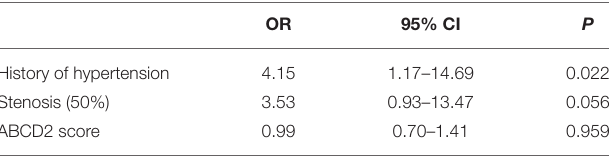
TABLE 2 | Possible predictors of T max ≥ 4s ≥ 10 ml in patients with TIA (univariate Binary logistic regression analysis).